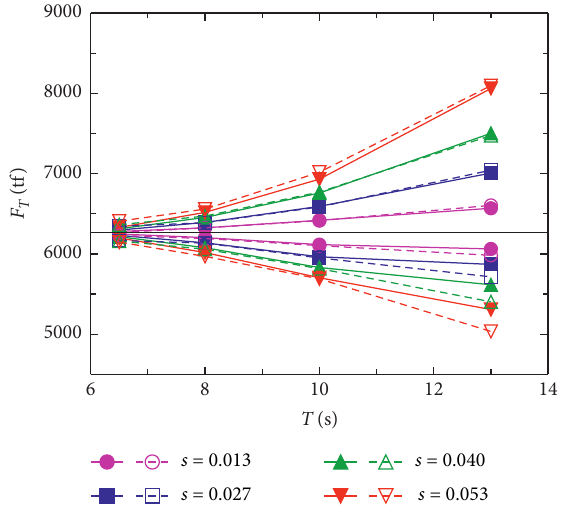
Figure 5: The average maximum value of tension force of a single mooring cable as a function of wave period (T). Solid lines and solid markers are numerical simulation results; dotted line and open markers are experimental